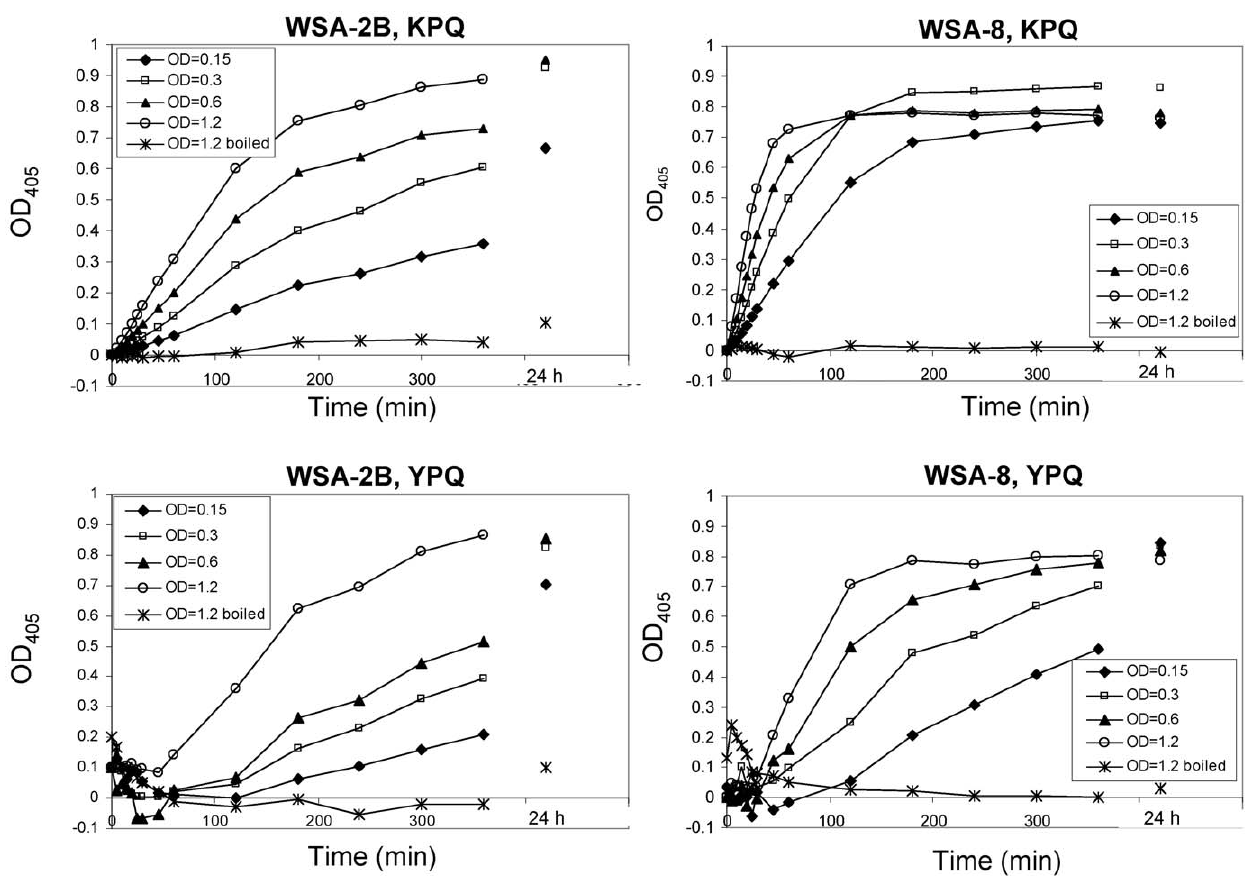
Figure 2. Relationship between cell density and proteolytic activity. WSA-2B ( R. mucilaginosa ) or WSA-8 ( R. aeria ) cells were suspended in saliva ion buffer to a final cell concentration of OD 620 0.15, 0.3, 0.6, and 1.2. Z-KPQ-pNA or Z-YPQ-pNA were added as enzymatic substrates to a final concentrations of 200 m M. Note that the rate of substrate hydrolysis increased with increasing cell density. As expected, boiled cell suspensions (OD 620 1.2) were devoid of enzyme activities.